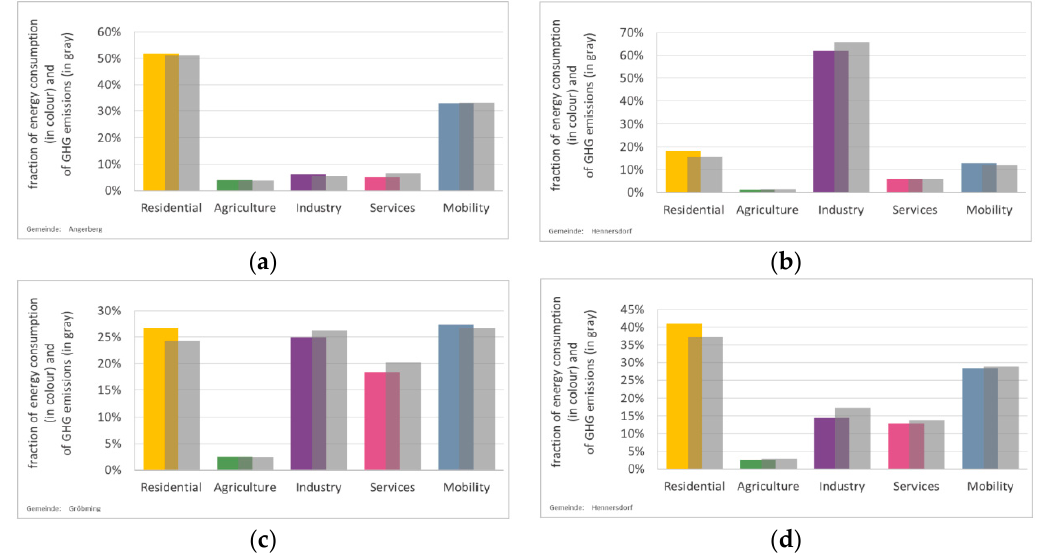
Figure 5. Energy consumption and GHG emissions after different types of land use. ( a ) Municipality Angerberg; ( b ) Municipality Hennersdorf; ( c ) Municipality Groebming; ( d ) Municipality Hennersdorf without energy intensive branches.